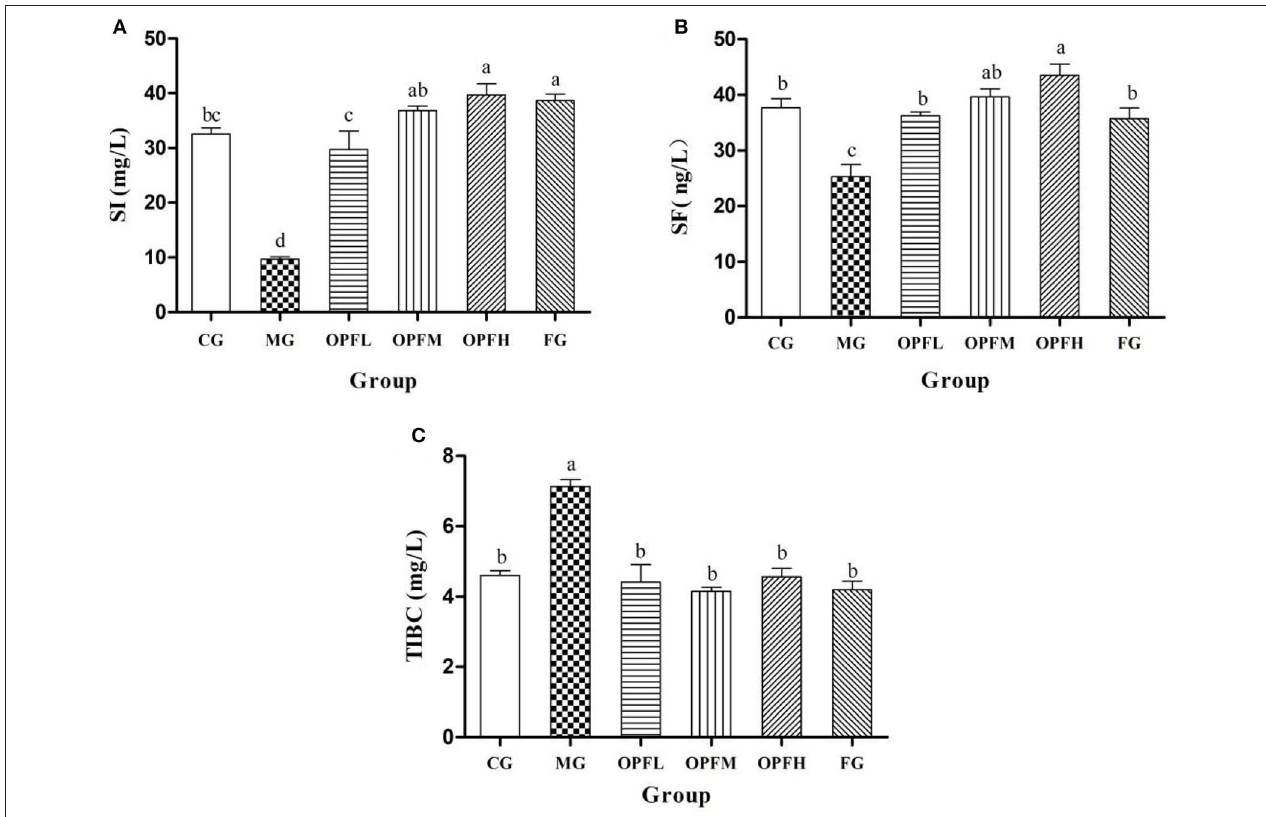
FIGURE 6 | Effect of different doses of OP-Fe 2 + and FeCl 2 on (A) SI, (B) SF, and (C) TIBC in IDA rats. Data are presented as mean ± SD ( n = 10). Different letters show statistically significant differences ( p < 0.05). The same letter in different groups indicates the absence of a statistical difference between these groups in the same period ( p >